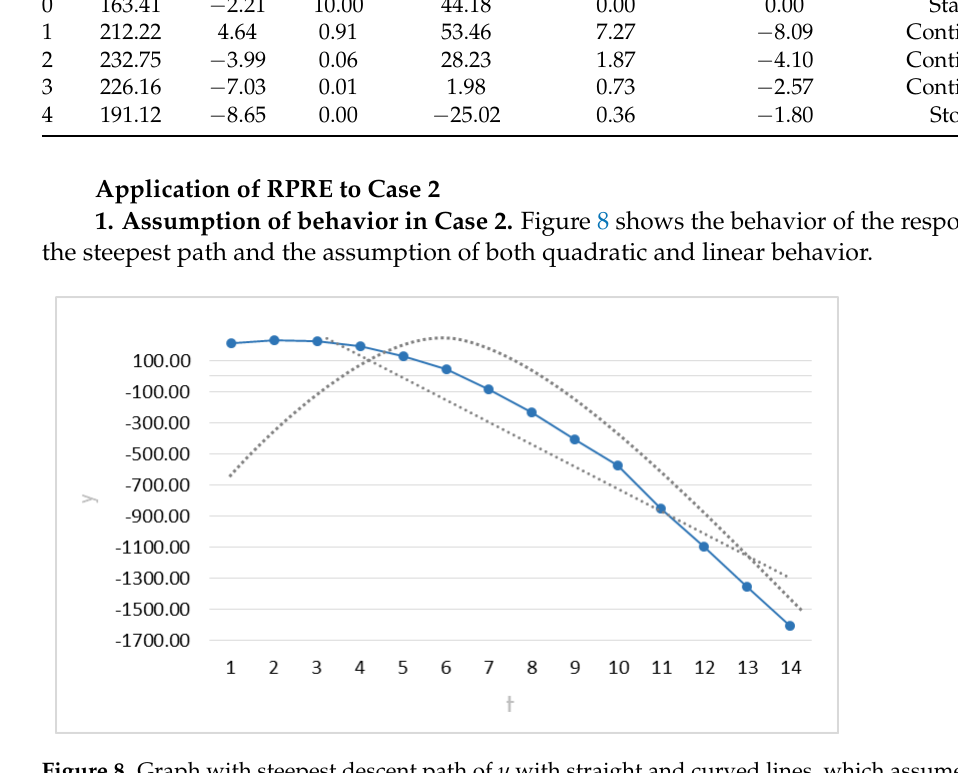
Figure 8. Graph with steepest descent path of y with straight and curved lines, which assumes both quadratic and non-quadratic behavior in Case 2.